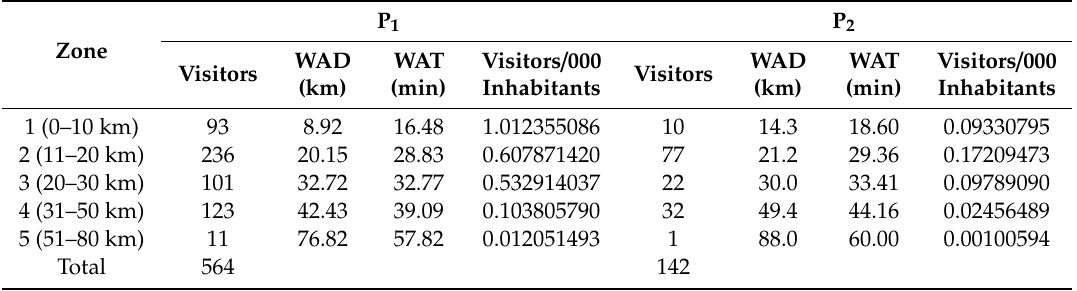
Table 3. Weighted Average Distance (WAD) and Weighted Average Time (WAT) taken by visitors of HNP for both periods.